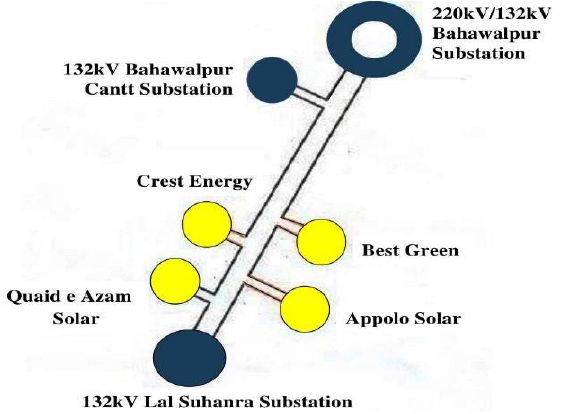
Fig. 11. Grid interconnection of QASPP & Crest